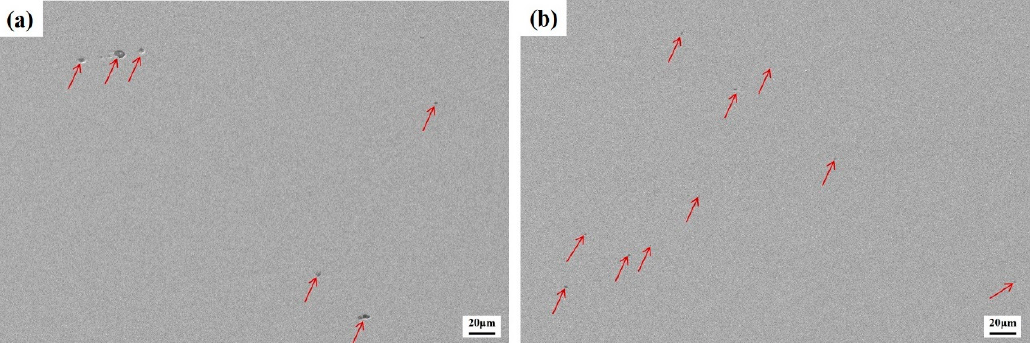
Figure 6. Comparison of inclusion distribution in Beam-1 ( a ) and Beam-2 ( b ) steels. The inclusion is marked by the red arrow.